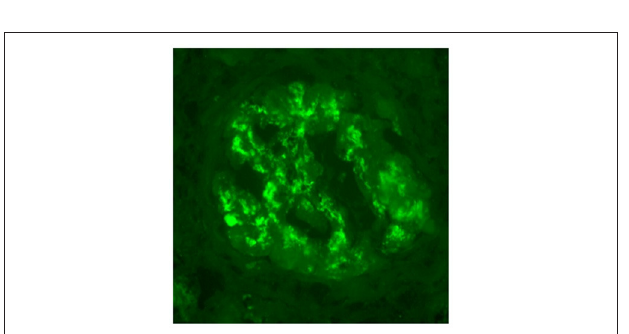
FIGURE 3 | Immunofluorescence microscopy. IgA deposits are observed within mesangium and glomerular membranes